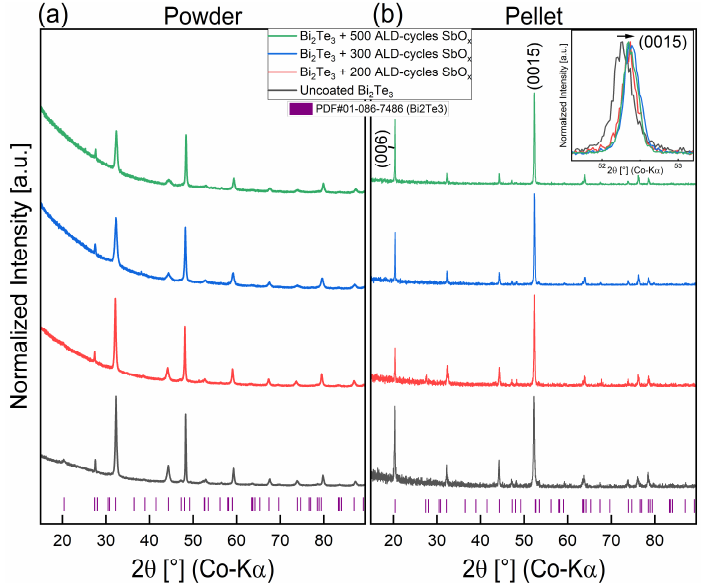
Figure 4. XRD pattern of ( a ) uncoated and SbO x -coated powders and ( b ) the sintered pellets. All diffractograms are matched to the Bi 2 Te 3 phase (PDF#01-086-7486).